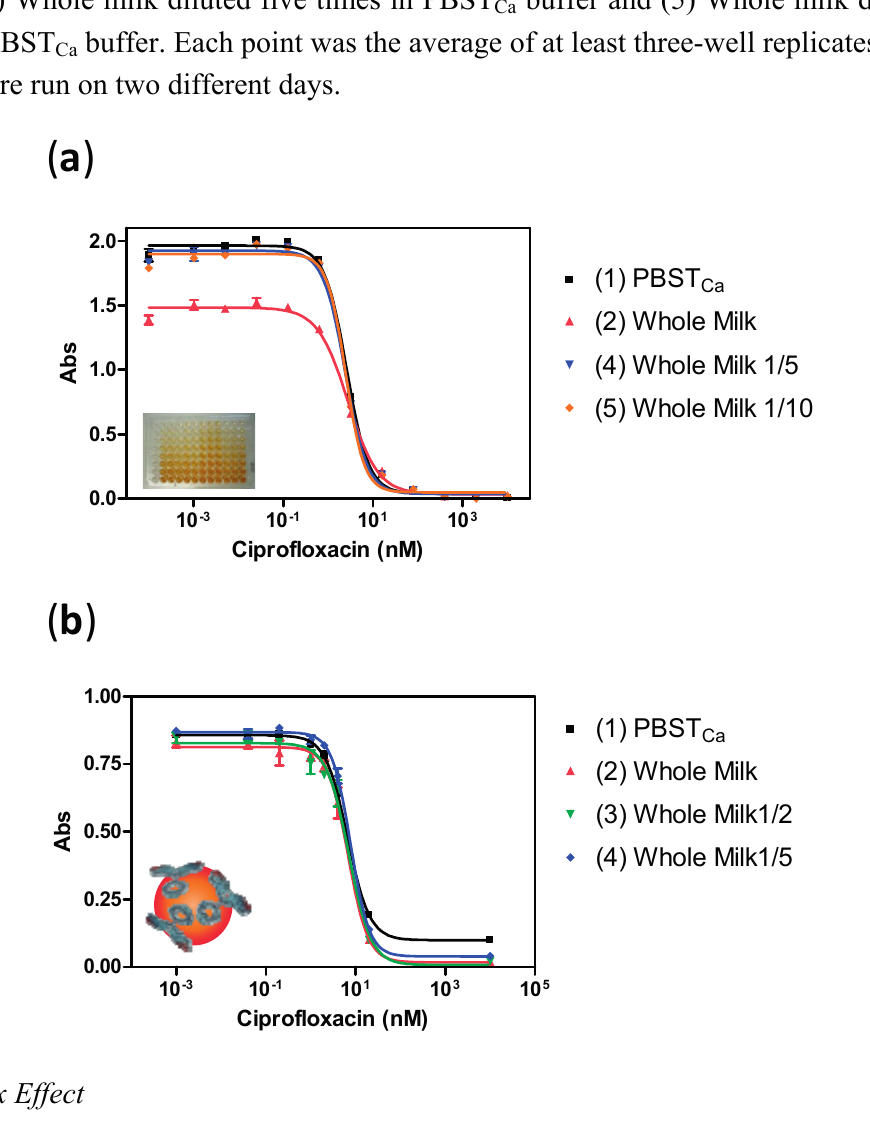
. Curves were f Ca buffer and (5) Whole milk diluted 10 Ca